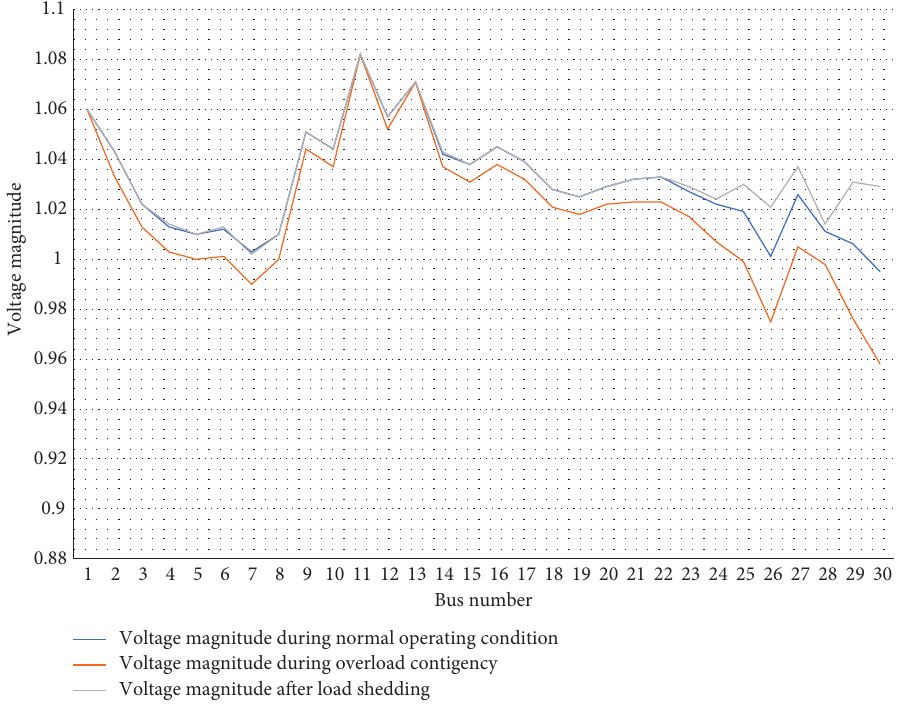
Figure 9: Bus voltage measurement.